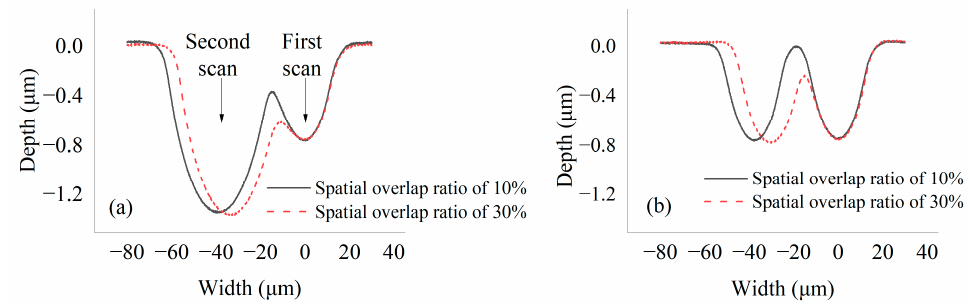
Figure 3. Structural profiles scanned at different spatial overlap rates for time intervals of ( a ) 0.1 s and ( b ) 30 s, respectively. In the graph, 10% and 30% indicate the spatial overlap ratios between the two scan lines, respectively.